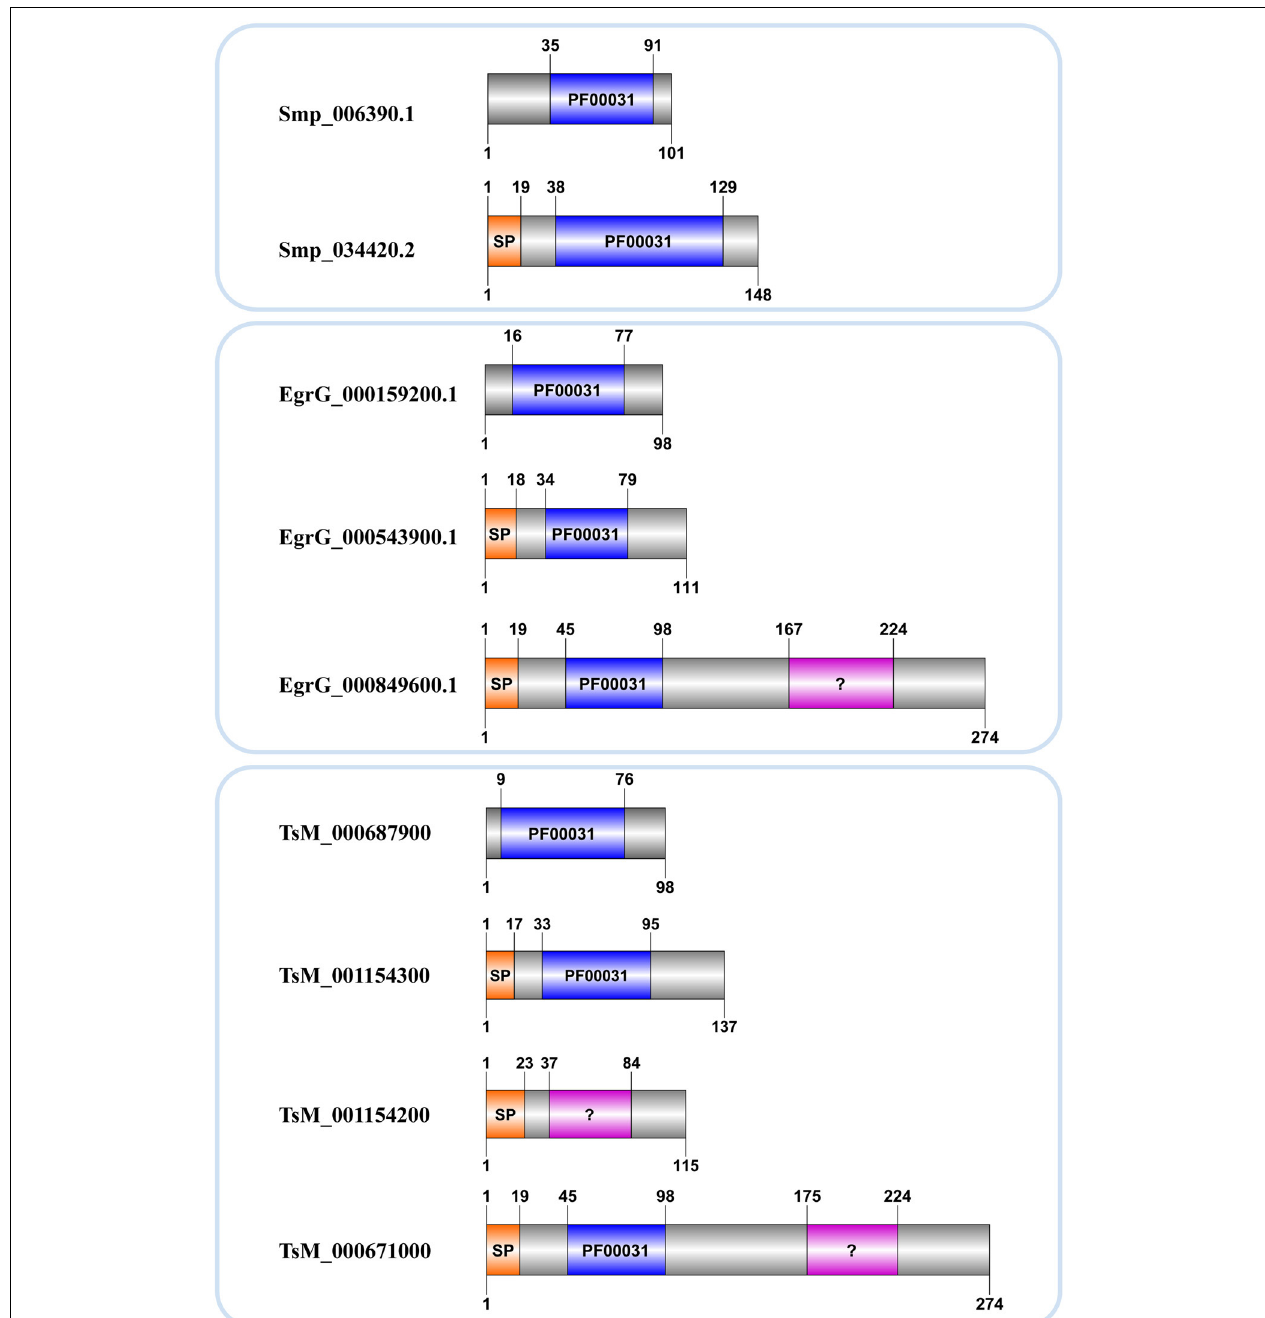
FIGURE 2 | Cystatin architecture in three Platyhelminthes. Accession numbers correspond to those assigned in each genome project. Domain limits (above) and sequence length (below) are provided for